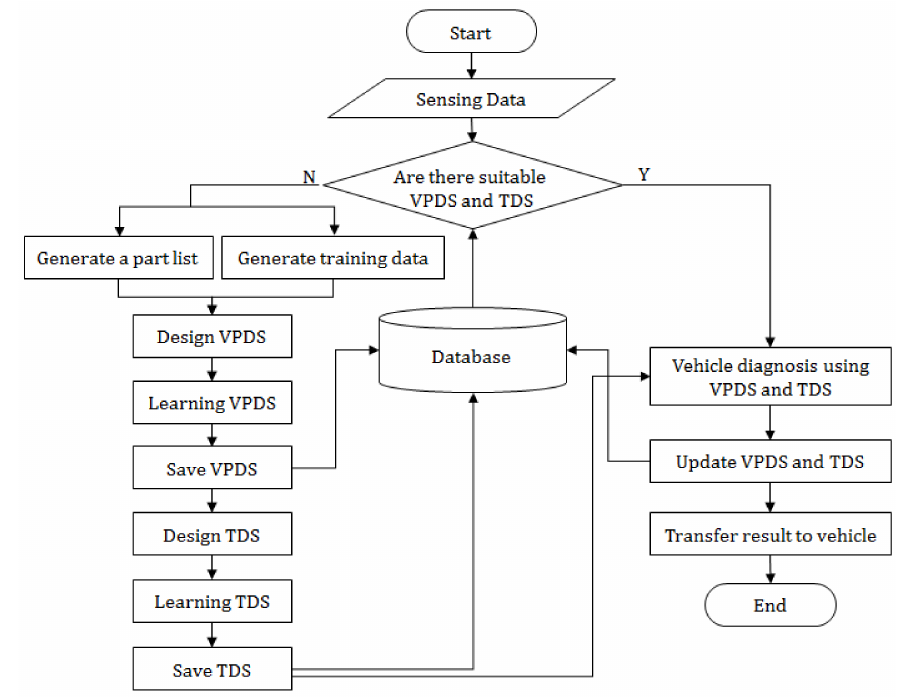
Figure 6. Flowchart about Optimized Deep Learning Module